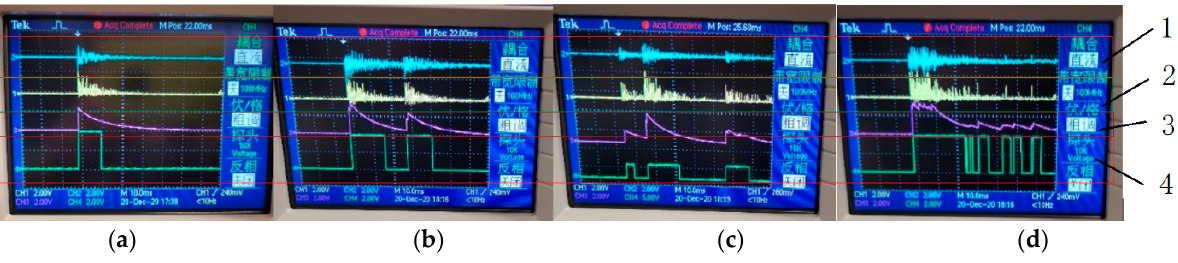
Figure 15. Multiple-channel oscilloscope signal display diagram. ( a ) One corn kernel; ( b ) two corn kernels; ( c ) three corn kernels; and ( d ) five corn kernels. ( 1 ) The signal through the detection piezoelectric element, ( 2 ) the signal through the detection piezoelectric element and high-pass filter, ( 3 ) the signal through the detection piezoelectric element, high-pass filter and envelope detection circuit, and ( 4 ) the signal through the detection piezoelectric element, high-pass filter, envelope detection circuit and voltage comparator.